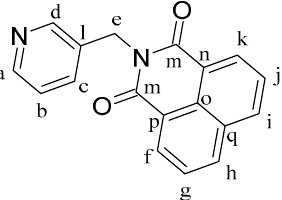
Figure 8. Structure of ligand N -(3-methylenepyridyl)-1,8-naphthalimide (L1).